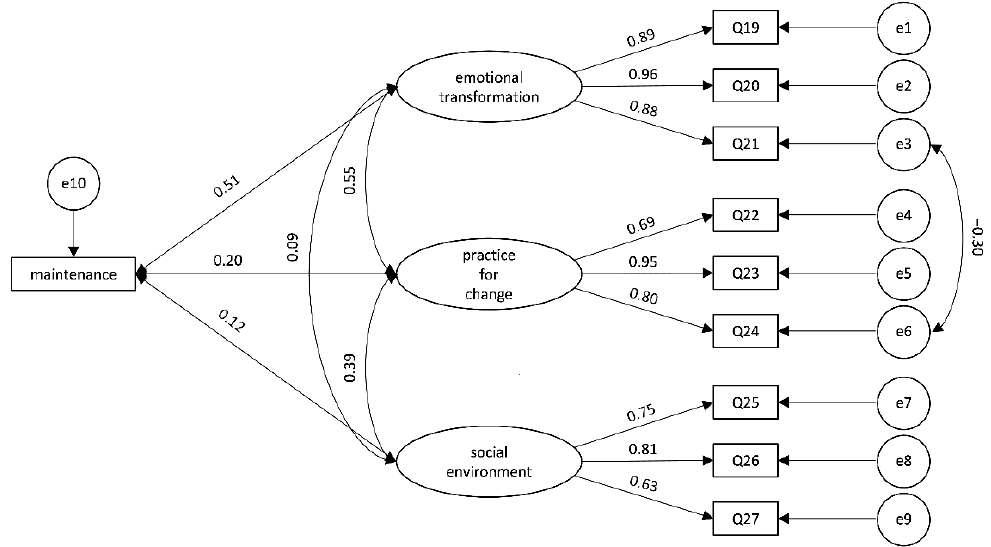
Figure 3. Structural equation model for maintenance model.